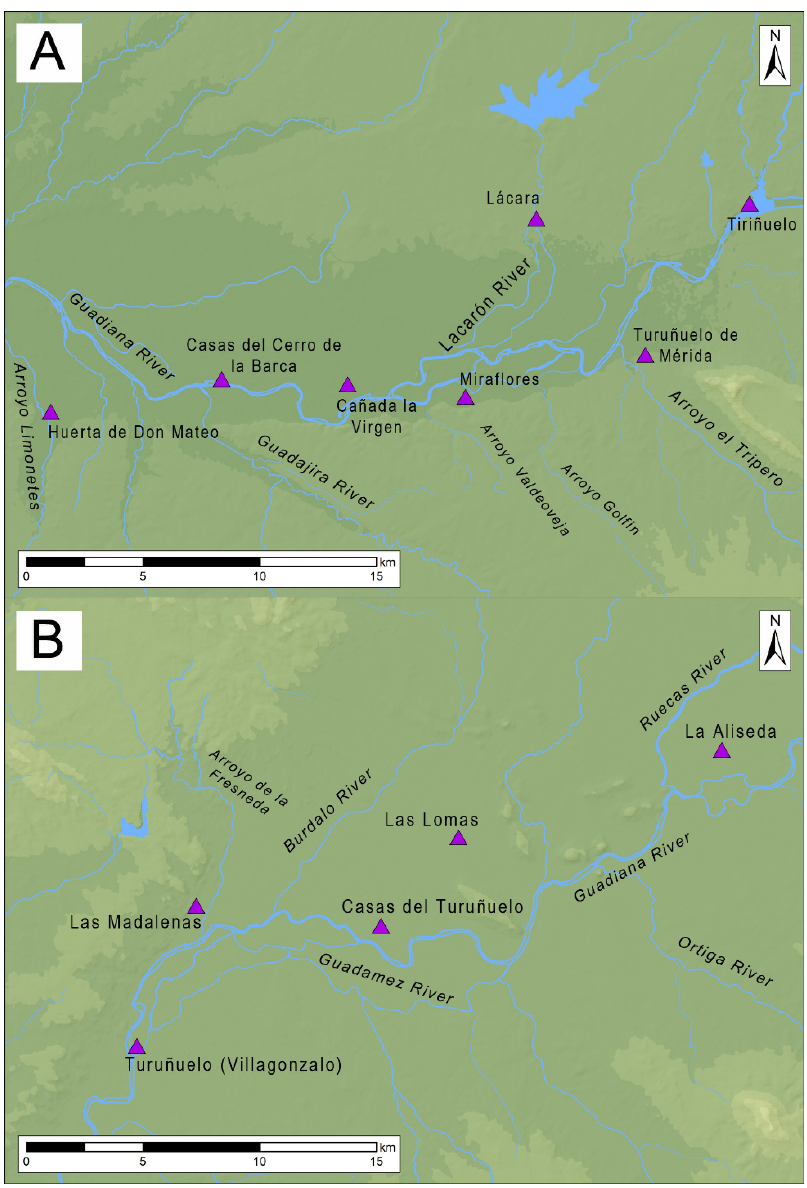
Figure 16. Maps ( A , B ) showing the location of the Tartessian buildings hidden under tumuli in relation to watercourses. The layout of these constructions always places them next to a watercourse, mainly along the Guadiana, the main communication artery of this territory.